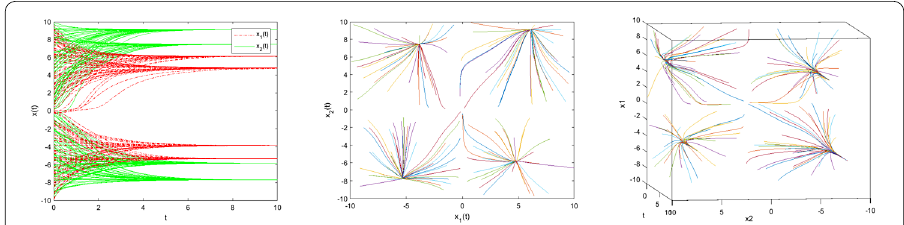
Figure 1 The state trajectories and phase plots of the neural network model (1). The above three graphs are the state trajectories and phrase plots, where the third graph is a 3 D phase plot of the state variable ( t , x 2 , x 1